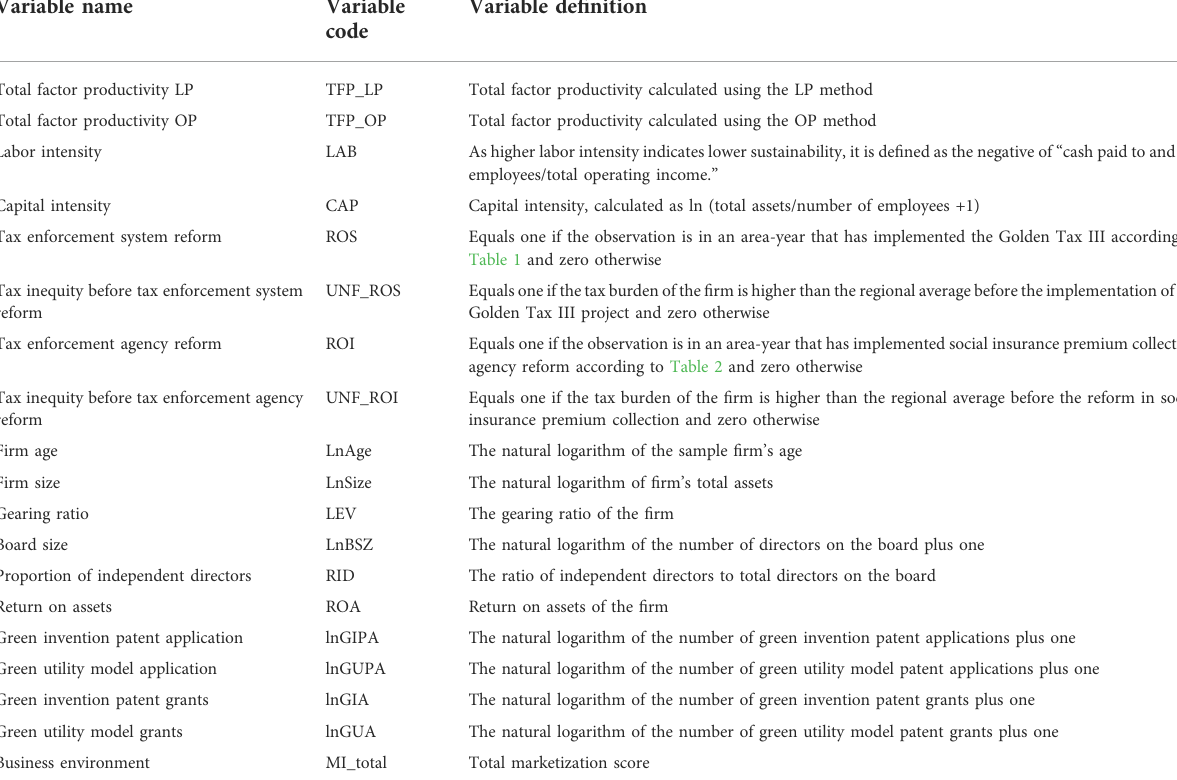
TABLE 3 Variable names and de fi nitions.